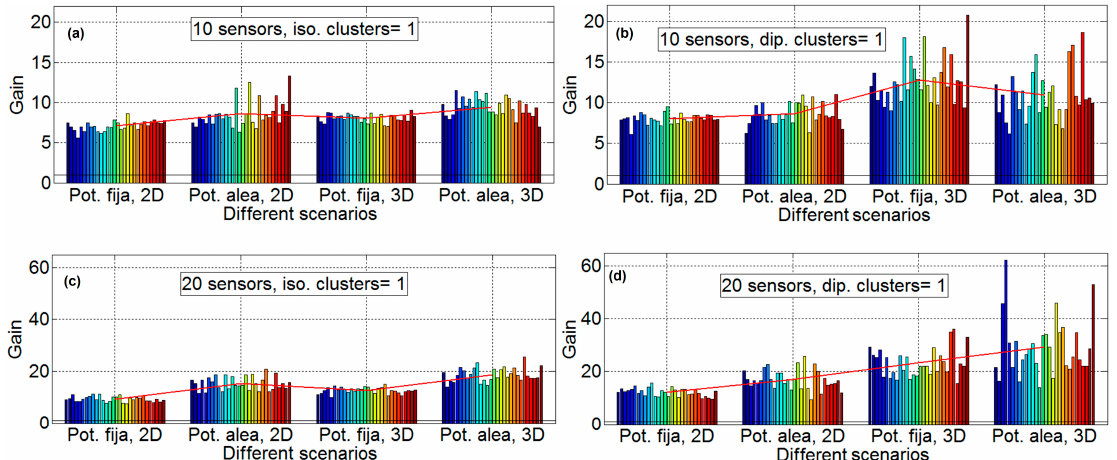
Figure 10. Gain results with one cluster, 10 and 20 sensors, all scenarios. Isotropic antenna and 10 sensors in subfigure ( a ) ( upper left ), dipole antenna and 10 sensors in subfigure ( b ) ( upper right ), isotropic antenna and 20 sensors in subfigure ( c ) ( lower left ), and dipole antenna and 20 sensors in subfigure ( d ) ( lower right ).